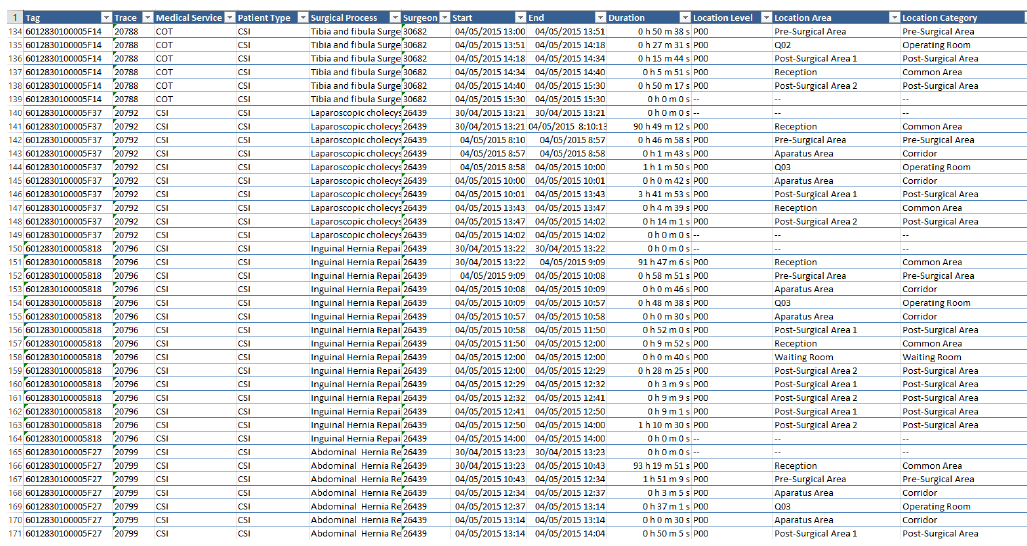
Figure 4. Example of data gathered from the ILS